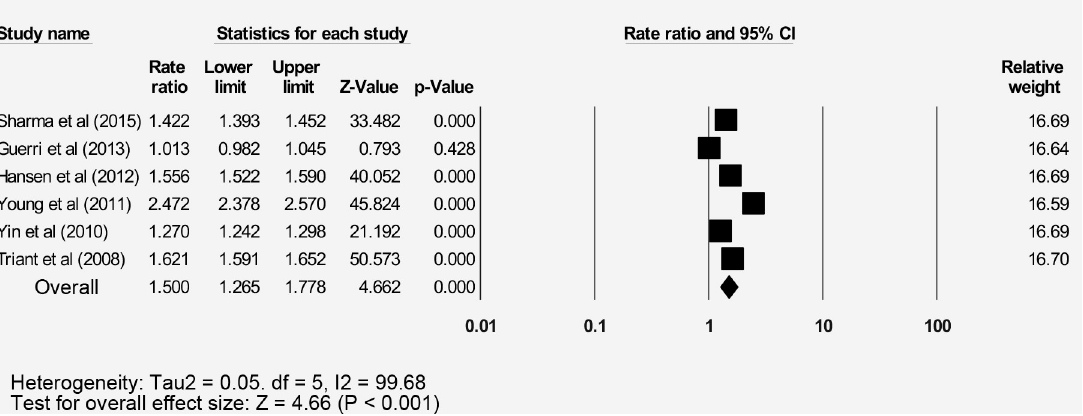
Fig 3. Forest plot for fracture incidence rate ratio between PLWH and general